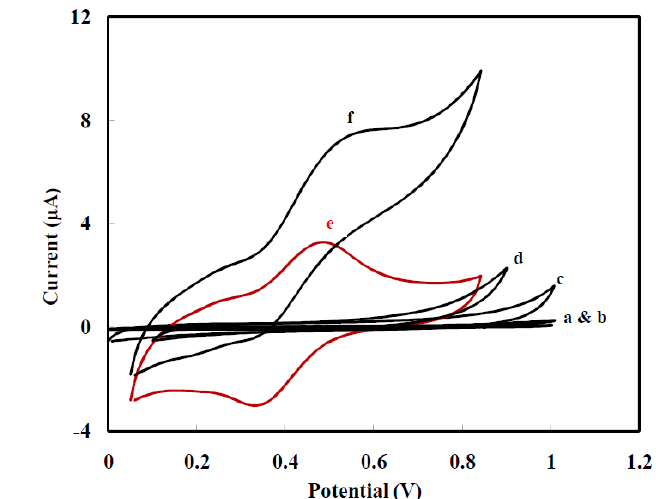
Figure 6. Cyclic voltammograms of Cu- complex/MWCNTs/GCE in buffer solution pH 8.0 at scan rate 10 mV s −1 in the absence (e) and presence 0.70 mM total sulfide (f), and cyclic voltammograms of GCE and MWCNTs modified GCE at similar conditions in the absence (a, c) and presence of 0.70 mM total sulfide (b,